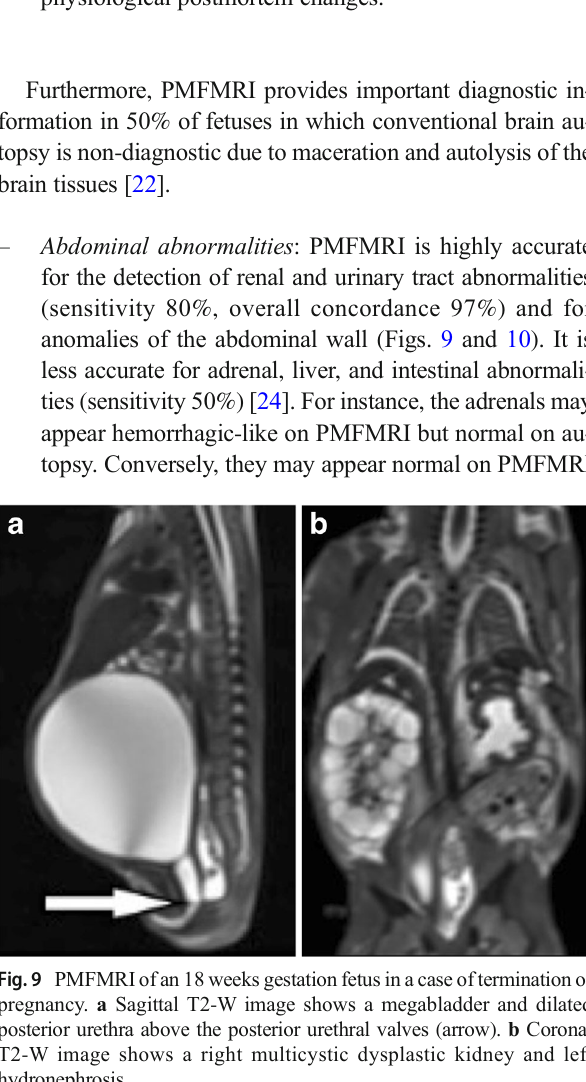
Fig. 6 PMFMRI of a 21 weeks gestation fetus who died in utero. Axial T2-W image shows indirect signs of corpus callosum agenesis. Note that there is a subcutaneous edema that has to be considered as a normal postmortem change